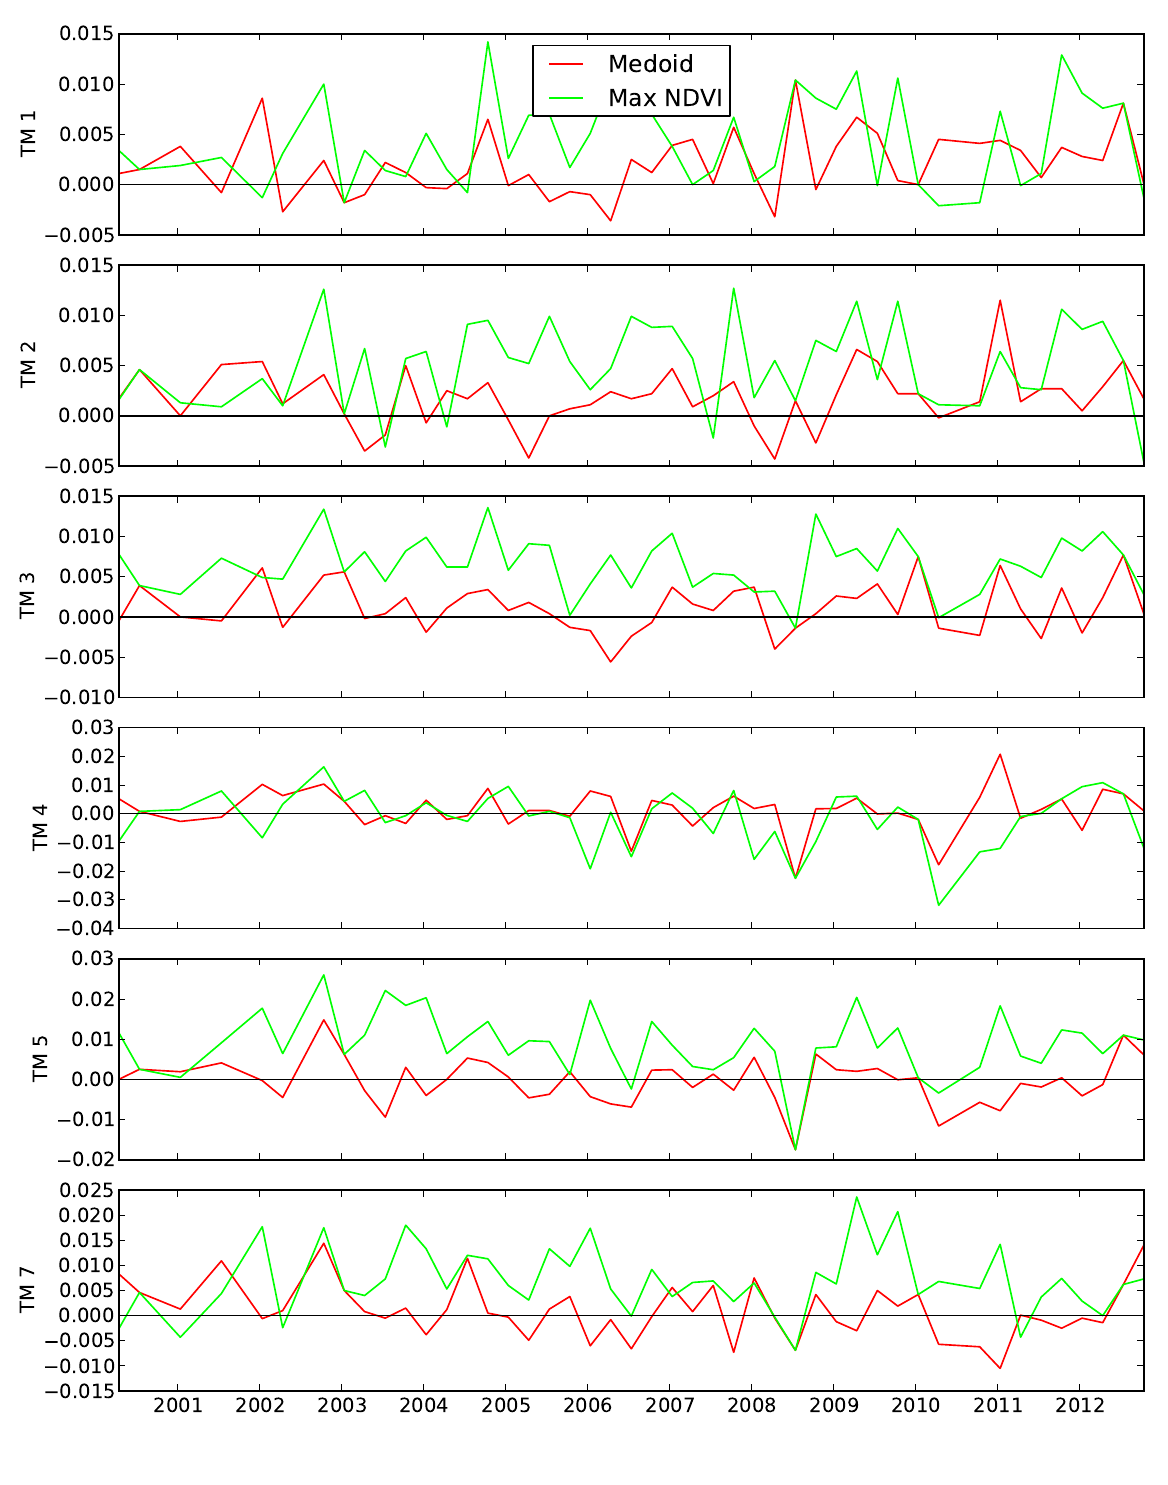
Figure 7. Seasonal average residuals for all Landsat TM reflective bands, for the forest example